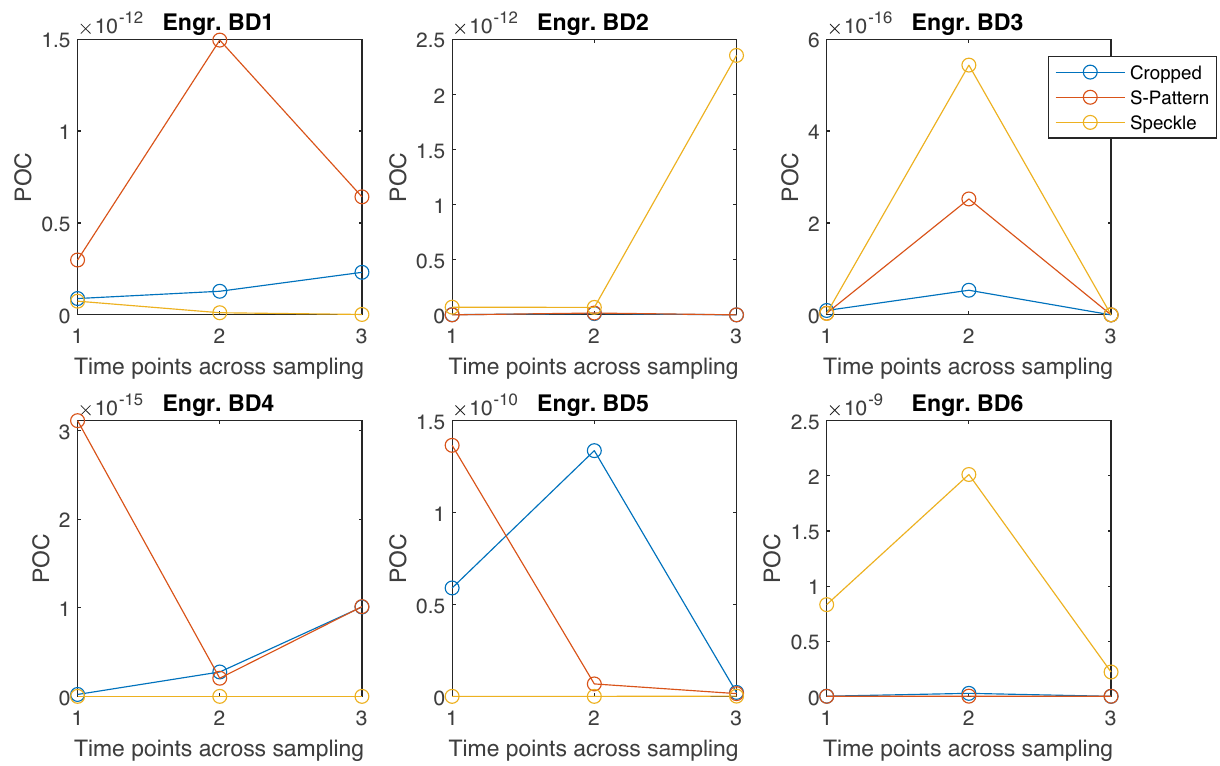
Figure 7. Probability of cloning for the 3 different datasets with cropped images (including S-pattern and speckle), only S-Pattern or only speckle around the pattern, across 3 time points within a week.